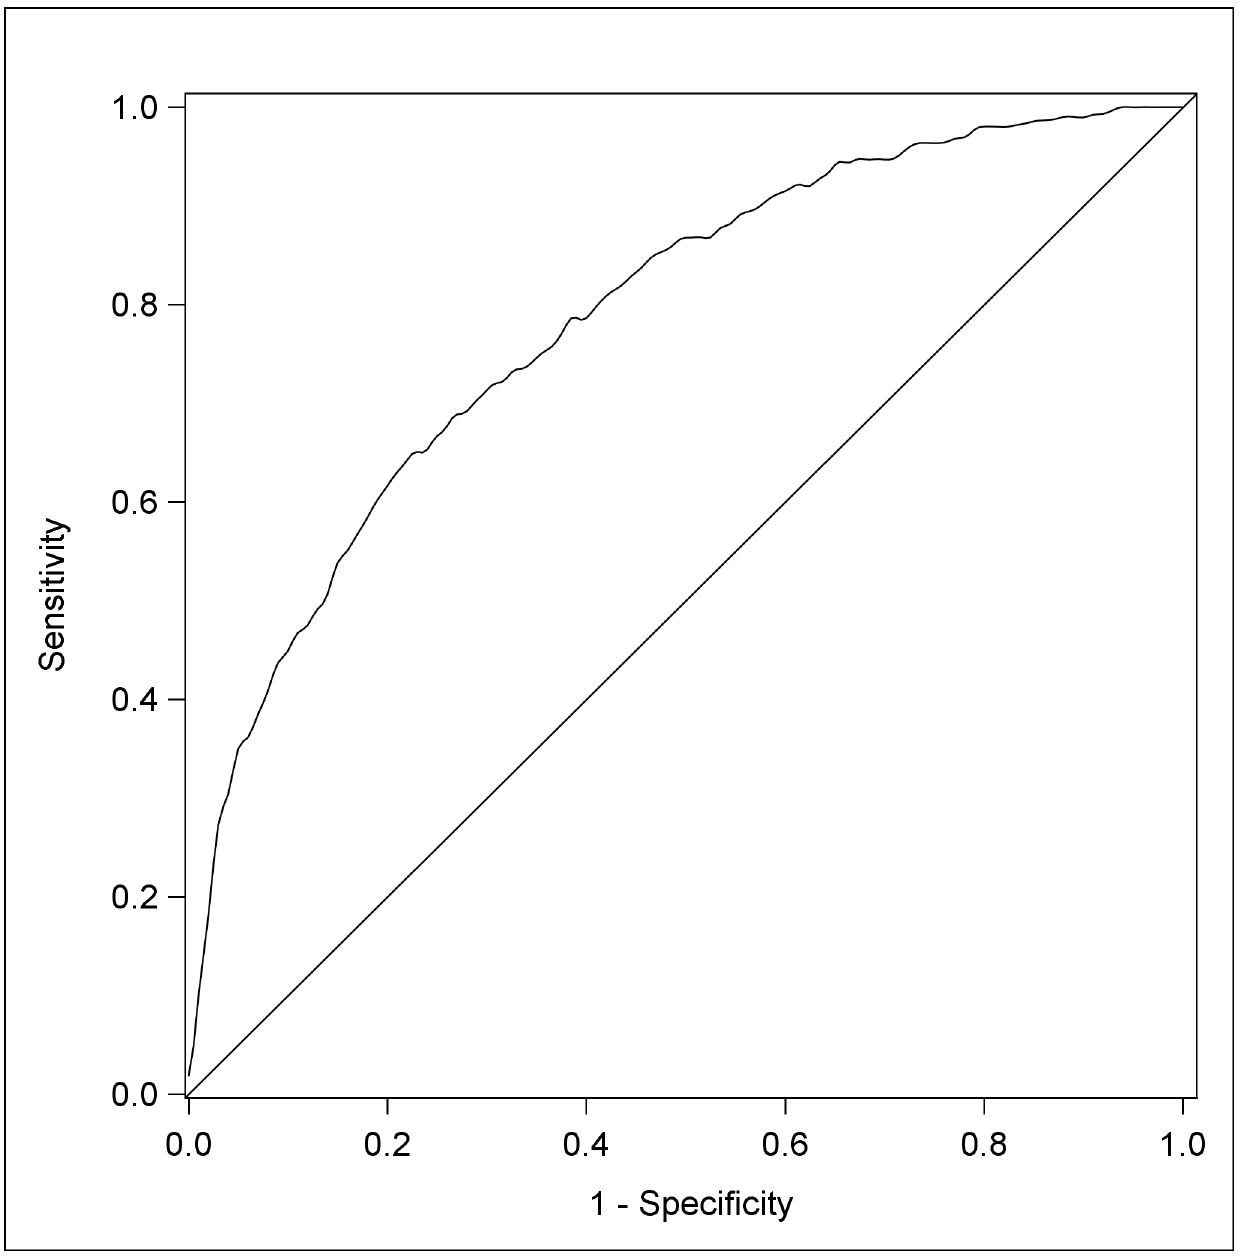
Fig 3. Sensitivity-Specificity Curve, Multivariate Logistic